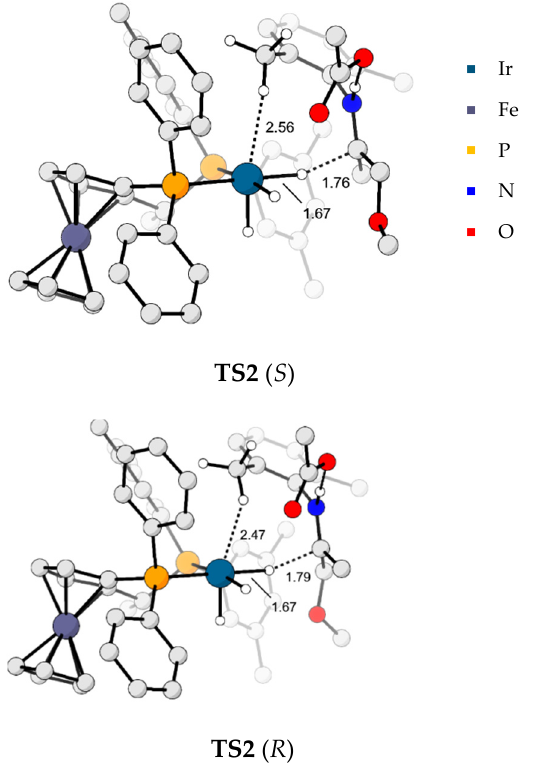
Figure 8. Prochiral structures of TS2 in acetic acid with relevant atomic distances reported in Å. Most C-H hydrogens were omitted for clarity.